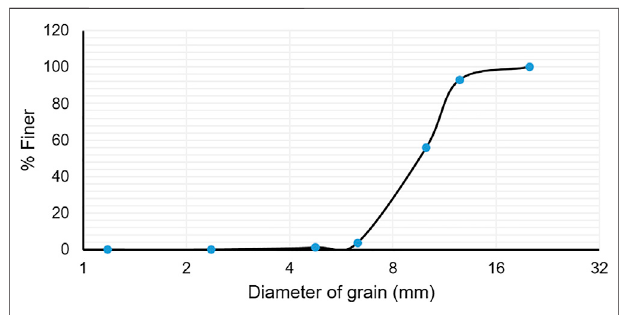
FIGURE 2 | Particle size distribution curve of coarse aggregates.